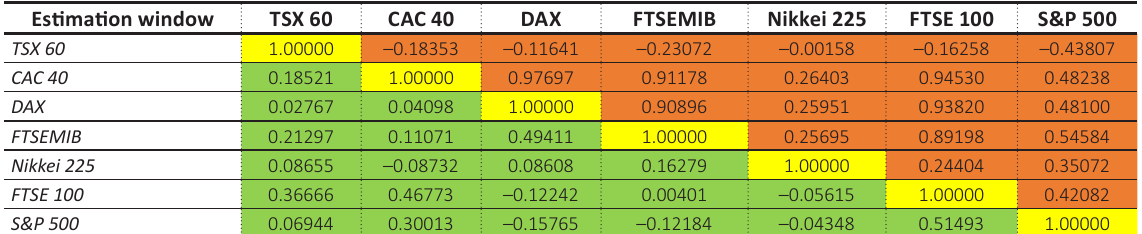
Table 9. Correlation matrix of G-7 nations in the estimation period and event